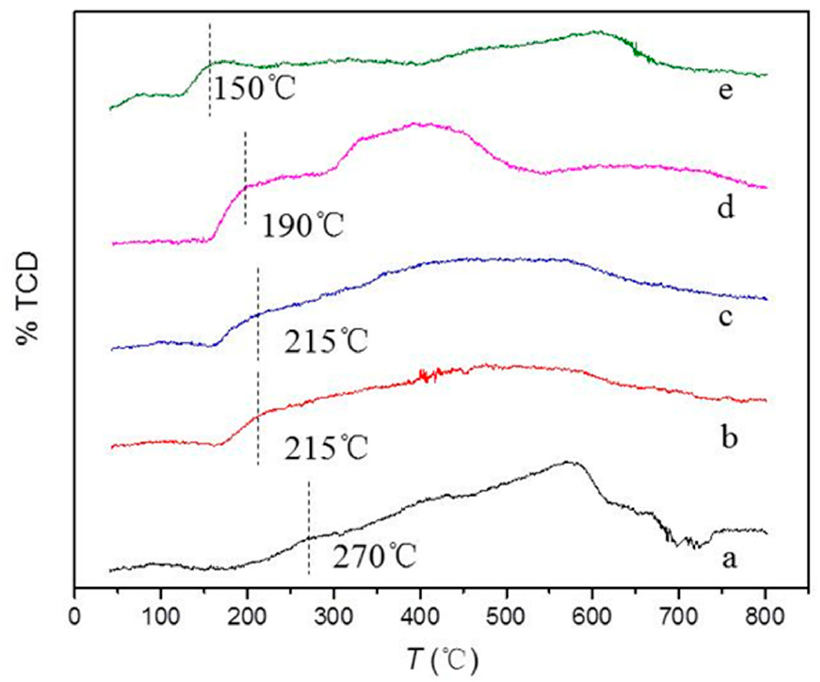
Figure 7. H 2 -TPD profiles of different catalysts: (a) 0.2% Pd/SiO 2 ; (b) 0.2% Pd-AlPO-5/SiO 2 ; (c) 0.2% Pd-AlPO-8/SiO 2 ; (d) 0.2% Pd-AlPO-11/SiO 2 ; (e) 0.2% Pd-AlPO-31/SiO 2.